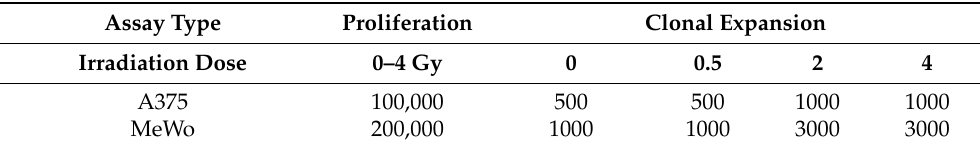
Table 1. Cell numbers used for set-up of proliferation and clonal expansion assays. Assay Type